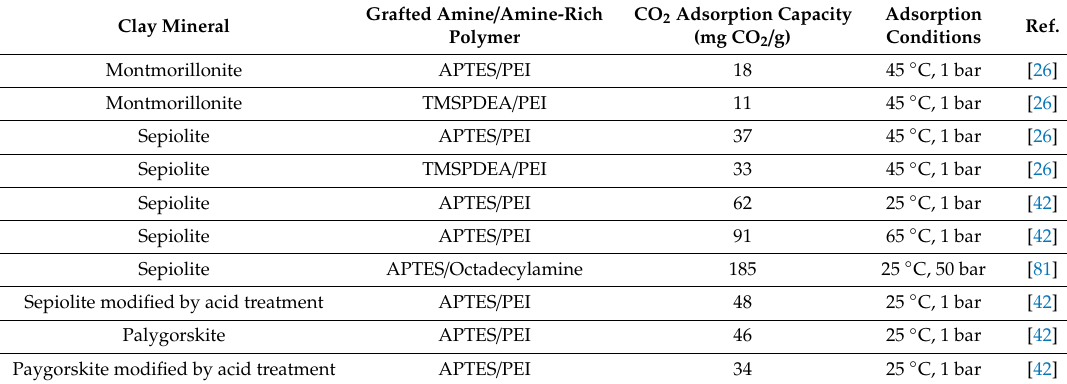
Table 7. CO 2 adsorption capacity of the clay minerals functionalized with amine groups in two steps (1st grafting, 2nd